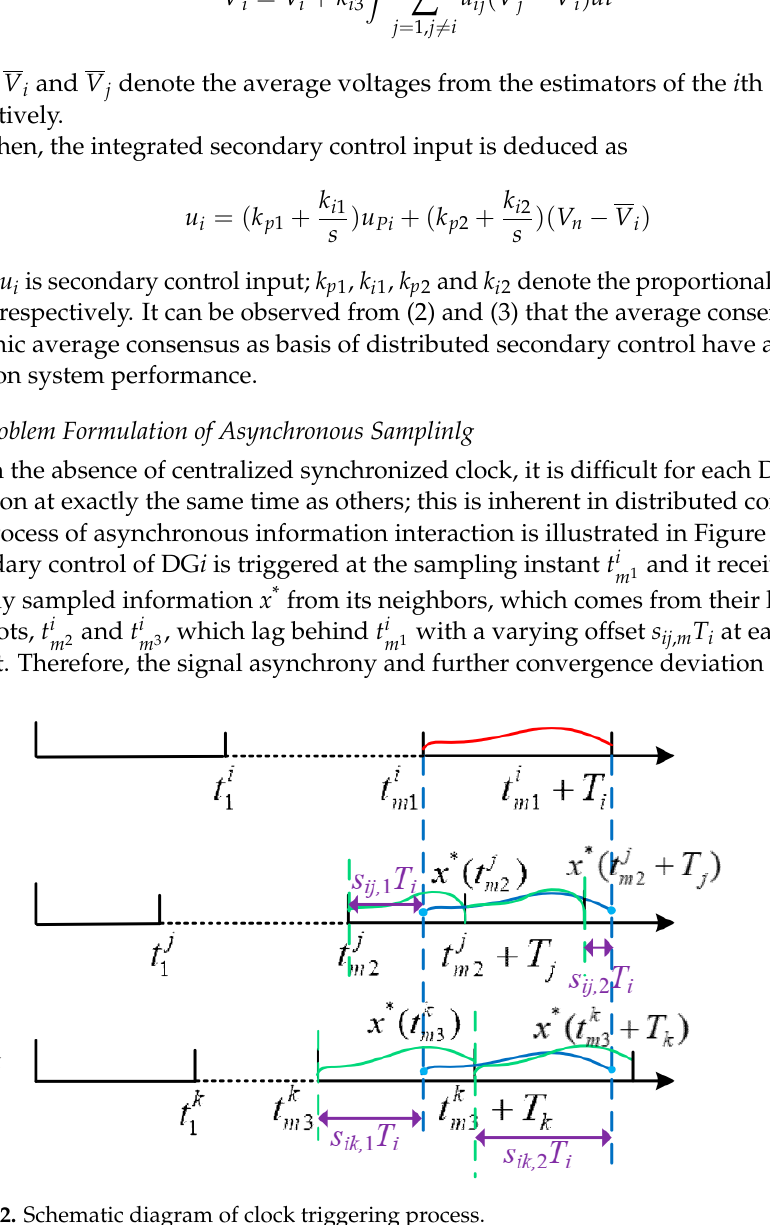
Figure 2. Schematic diagram of clock triggering